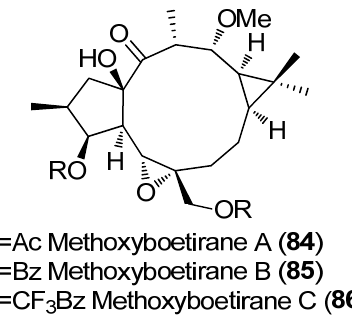
Figure 10. Chemical Structures of methoxyboetiranes A–C ( 84 – 86 ).